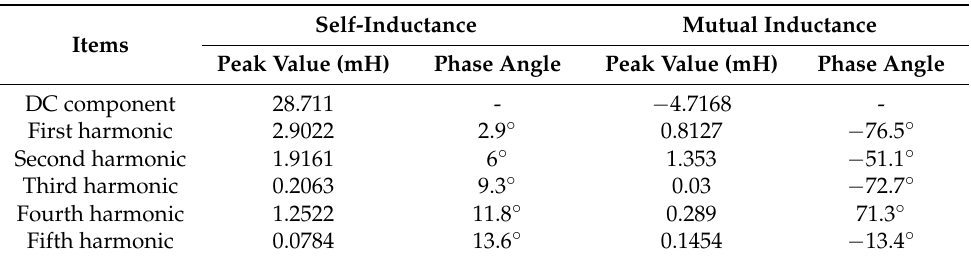
Table 1. Inductance characteristics in stator reference frame.